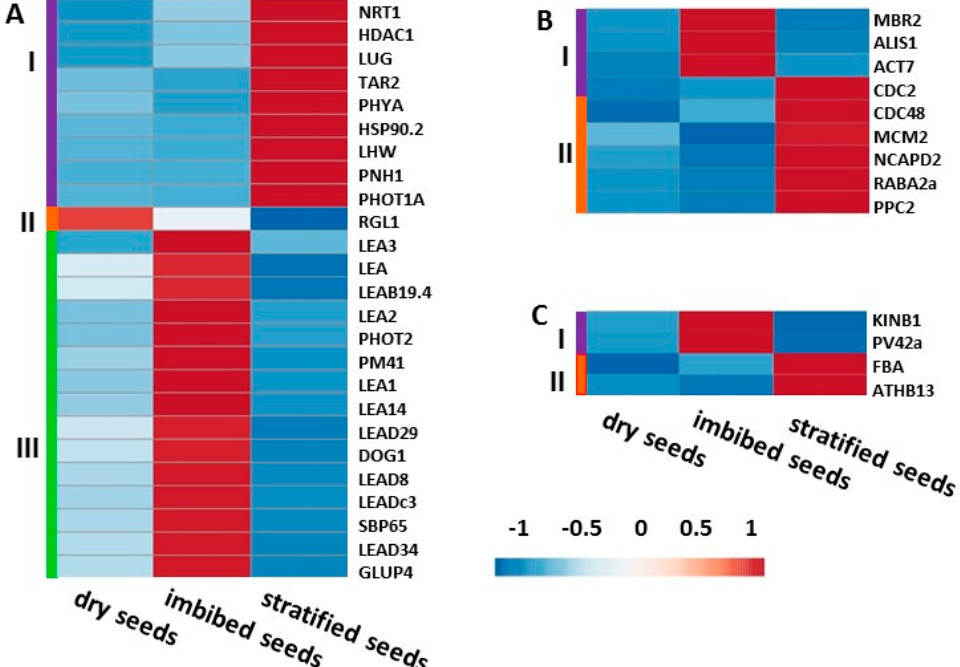
Figure 7. Hierarchical cluster analysis of gene expression patterns in dry, imbibed, and stratified garlic seeds. Unit variance scaling is applied to FPKM expression values. Genes are clustered using Pearson correlation distance and average linkage. Main clusters are shown by colors and Roman numerals. ( A ) Genes associated with seed dormancy and germination. ( B ) Genes associated with cell proliferation and division. ( C ) Key genes in glycolysis and glucose transport.